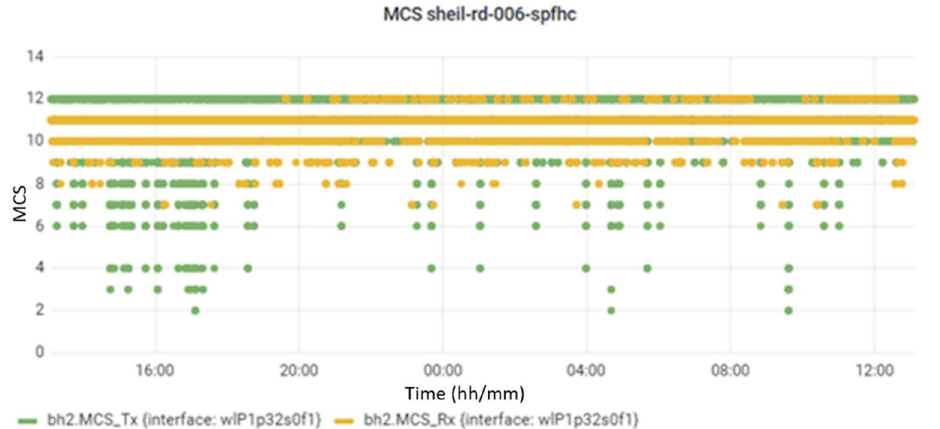
Figure 12. Performance in terms of MCS of Link 3.